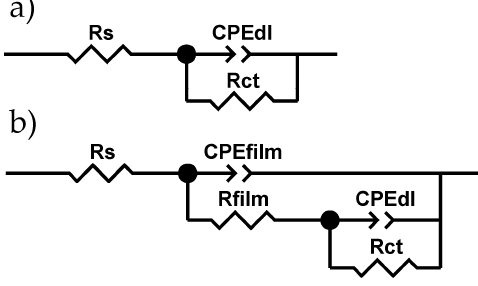
Figure 8. Electric equivalent circuits used for fitting the experimental spectra of a ) blank and b ) composite Ni coatings. ( b ) composite Ni